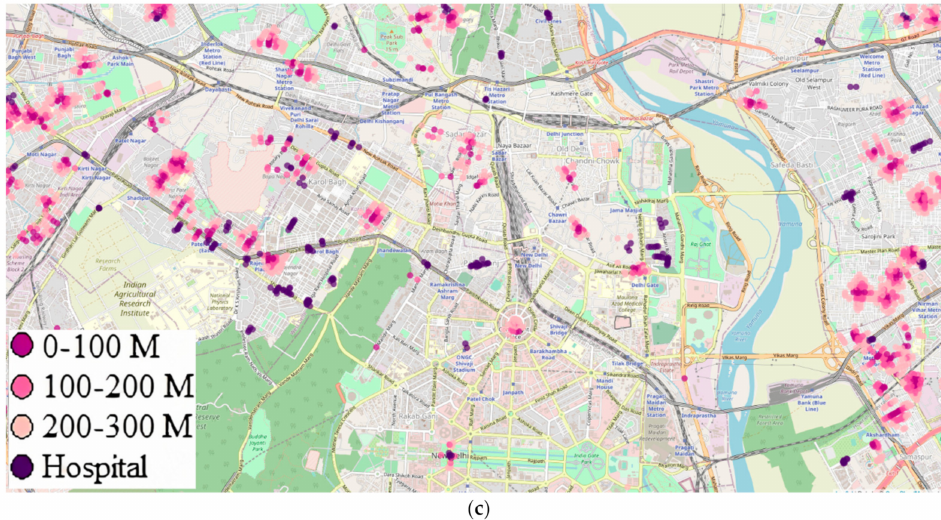
Figure 3. ( a ) Hospital and hotspot zone marked nodes in Delhi region. ( b ) A zoomed-in view of a region in Delhi. ( c ) Interactive visualization using the Folium